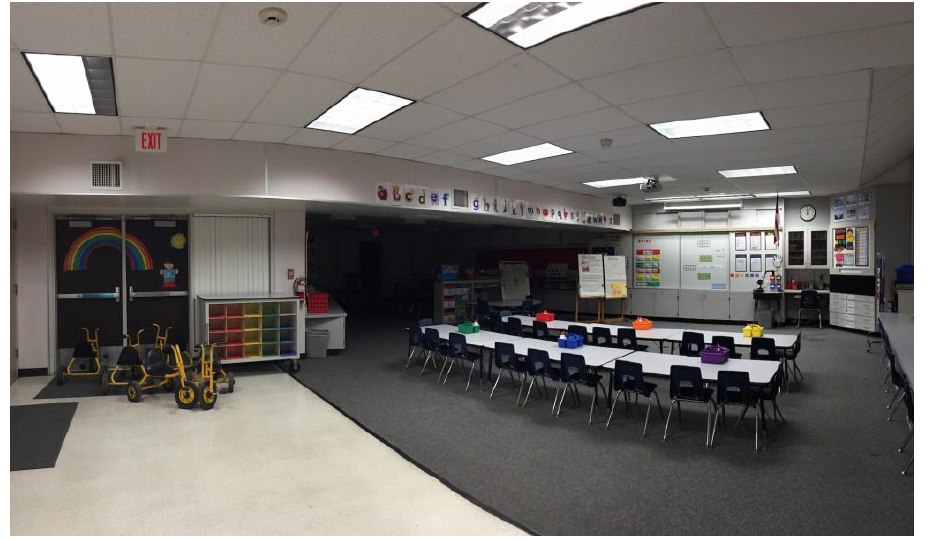
Figure 3. Sort of a Classroom